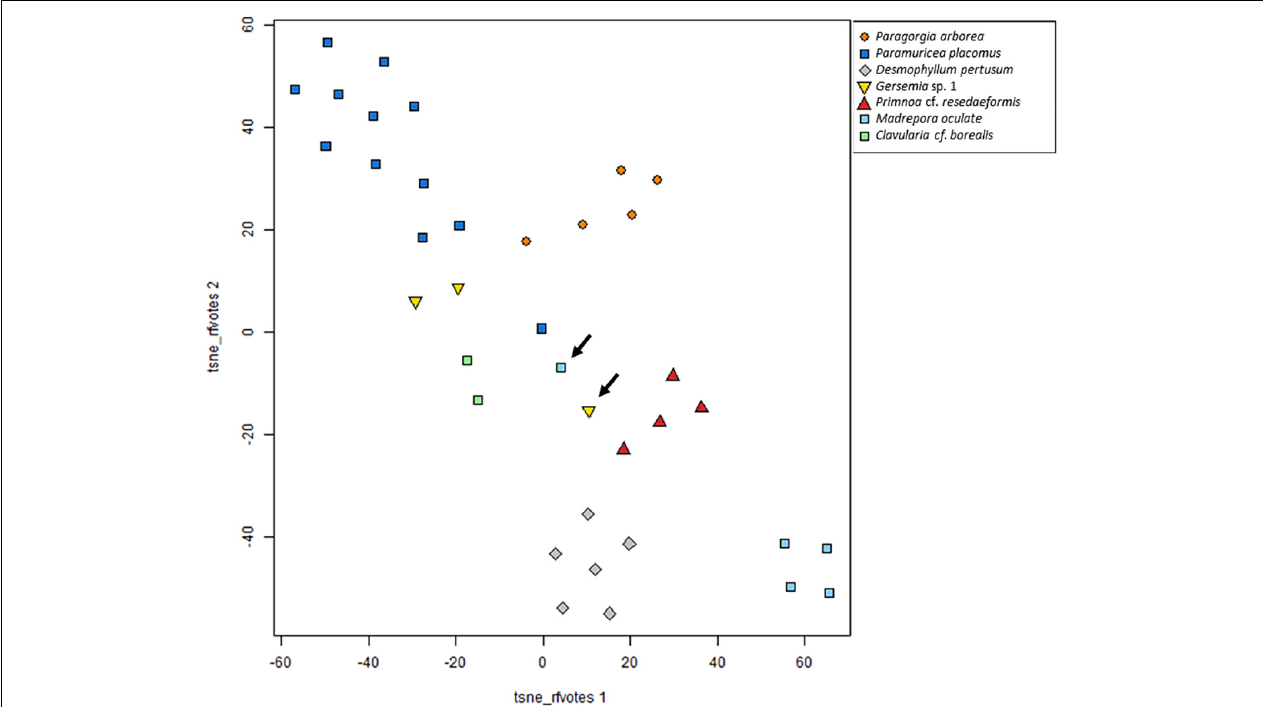
FIGURE 5 | t-SNE plot of Hellinger transformed raw data including species for which at least two specimens were analyzed. In the graph, most species are concerted. Specimens located further away from conspecifics are also supported in hierarchical cluster analysis. Arrows indicate outliers of Madrepora oculata and Gersemia sp.